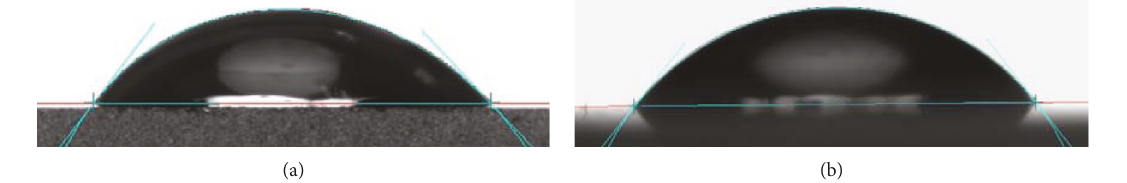
Figure 6: The contact angles of (a) SG-TiO